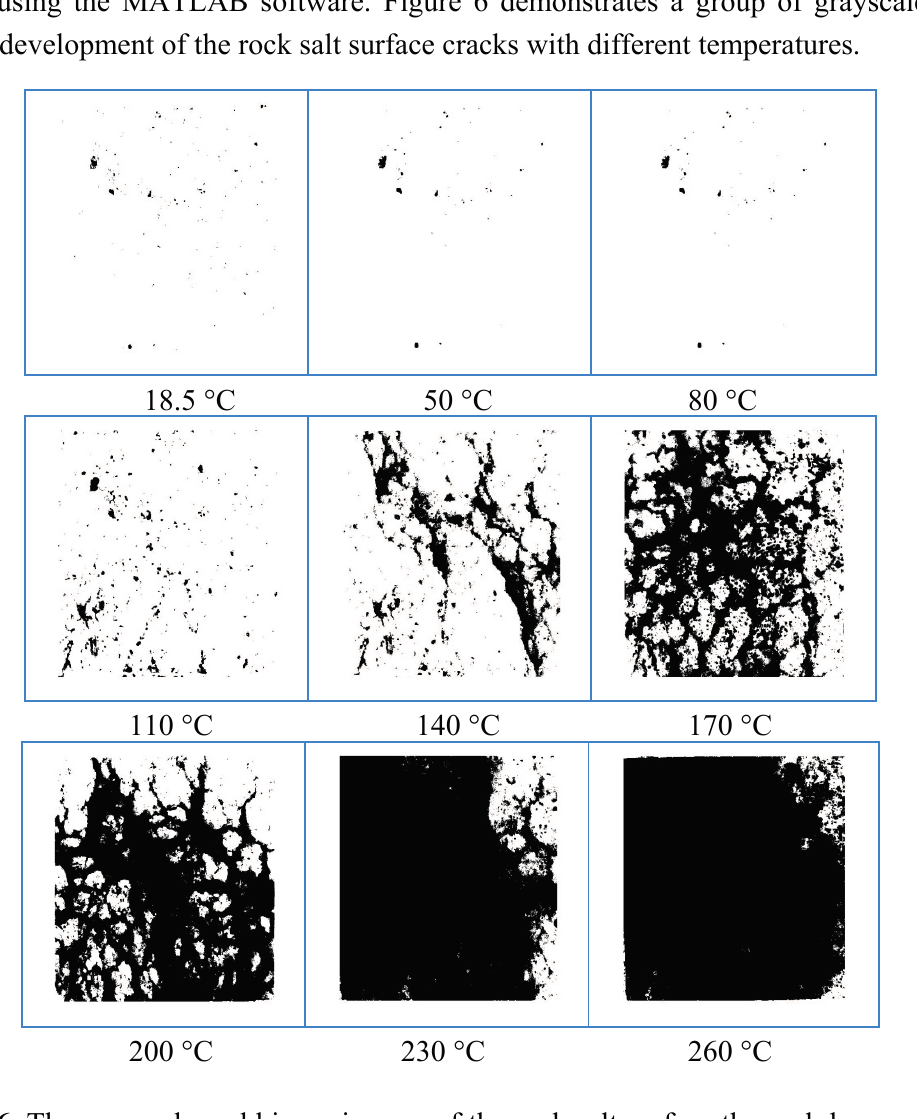
Figure 6. The grayscale and binary images of the rock salt surface thermal damage cracks at different temperature keep for 24 h from 18.5 to 260